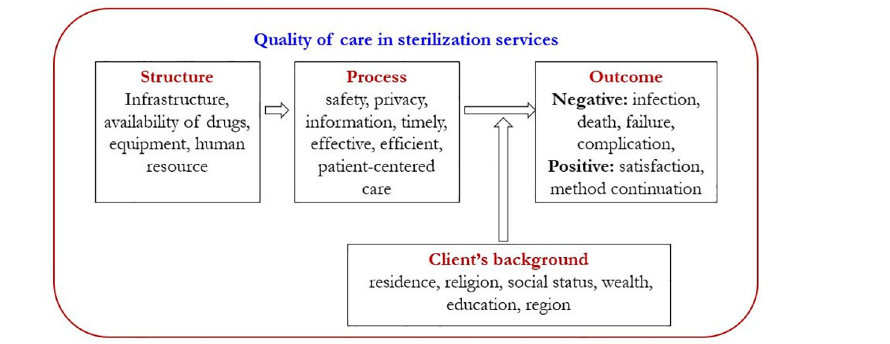
Fig 1. Framework of quality of care in sterilization